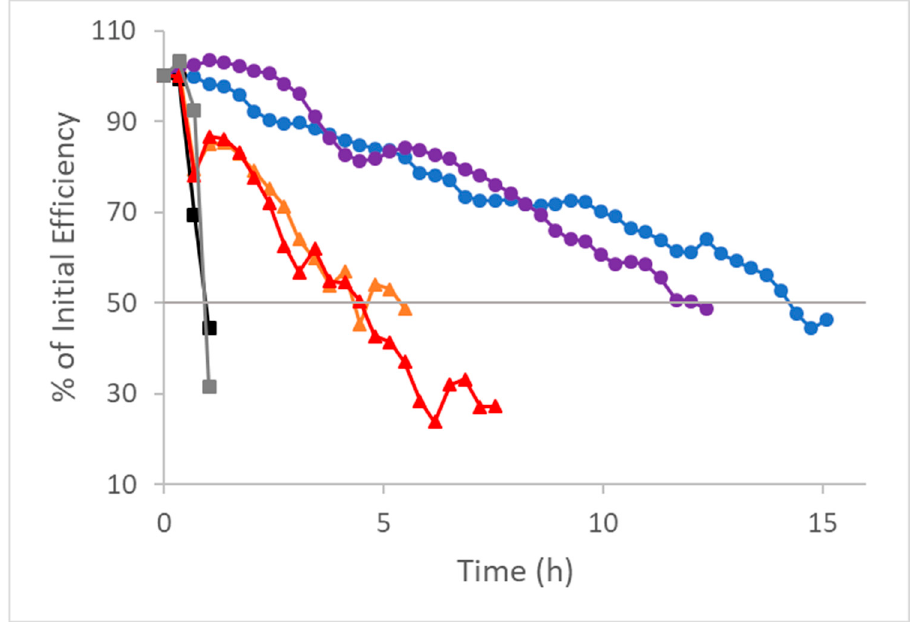
Figure 1. Effect of the water concentration of the challenge solution on the stability of 2.1 × 50 mm 1.6 µm CORTECS HILIC columns, shown as % of initial efficiency vs. time exposed to the basic solution. The columns were exposed at 70 °C to solutions containing acetonitrile and an aqueous pH (cid:3050)(cid:3050) 11.00 ammonium bicarbonate buffer (blue and purple circles, 20% buffer, pH (cid:3050)(cid:3046) 10.11; orange and red triangles, 40% buffer, pH (cid:3050)(cid:3046) 10.37; black and gray squares, 60% buffer, pH (cid:3050)(cid:3046) 10.54).